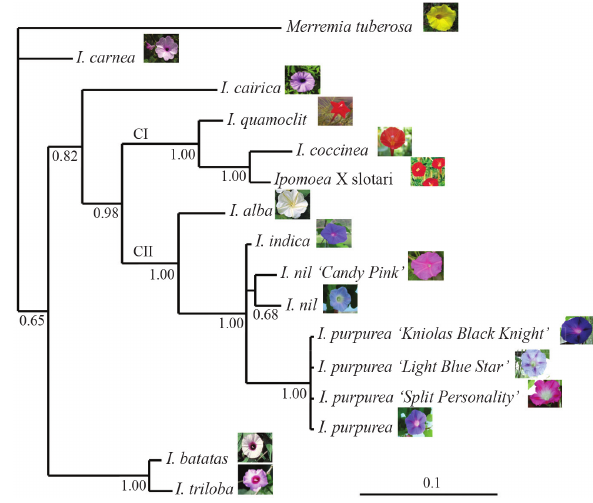
Figure 2 - Phylogenetic tree of the ITS region, as defined through Bayesian analysis. The evolutionary model used was GTR+G. The num- bersonthebranchcorrespondtoposteriorprobabilitiesestimatedfromthe Bayesian analysis. M. tuberosa was used as outgroup. Clades I and II (in- dicated by CI and CII) are as described by Miller et al.